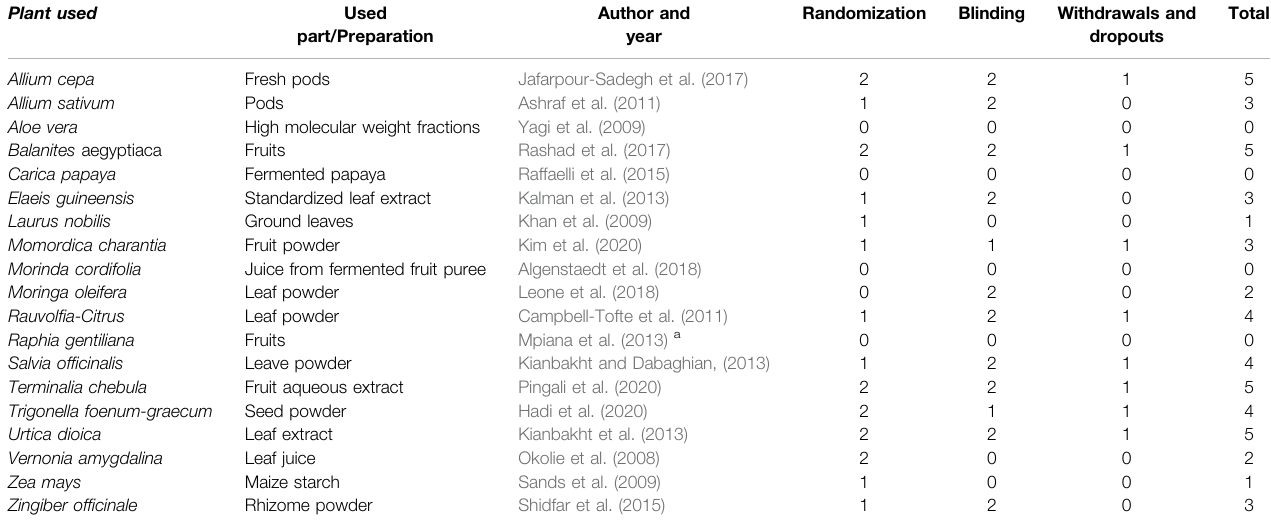
TABLE 5 | The interpretation of Jadad score on Clinical trials of antidiabetic plants found in DRC. Plant